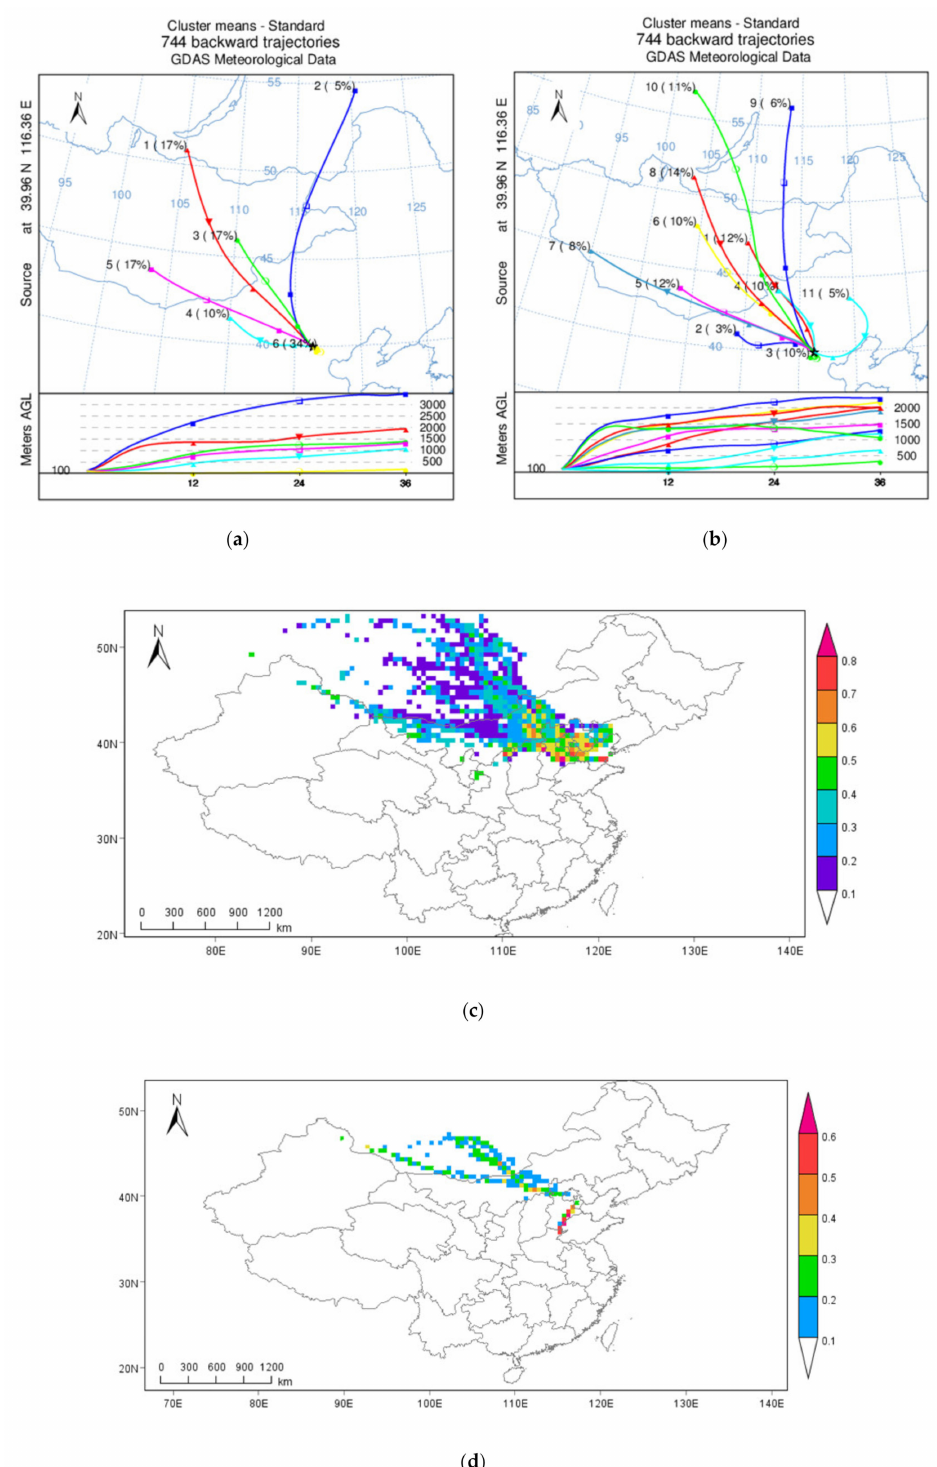
Figure 2. Backward trajectory and potential source analysis. ( a ) Backward trajectory analysis in January 2013; ( b ) backward trajectory analysis in January 2018; ( c ) potential source analysis in January 2013; ( d ) potential source analysis in January